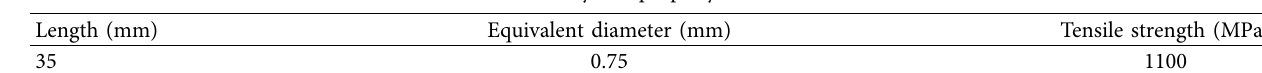
Table 2: Physical property index of SF.